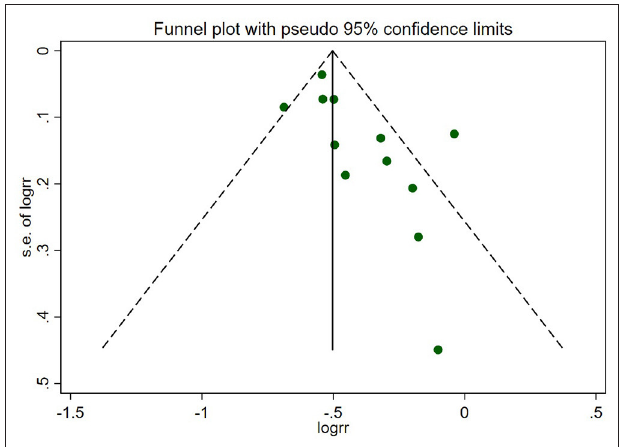
FIGURE 8 | Funnel plot of the primary outcome. The circles represent the included studies. The plot suggested that there may be publication bias in this